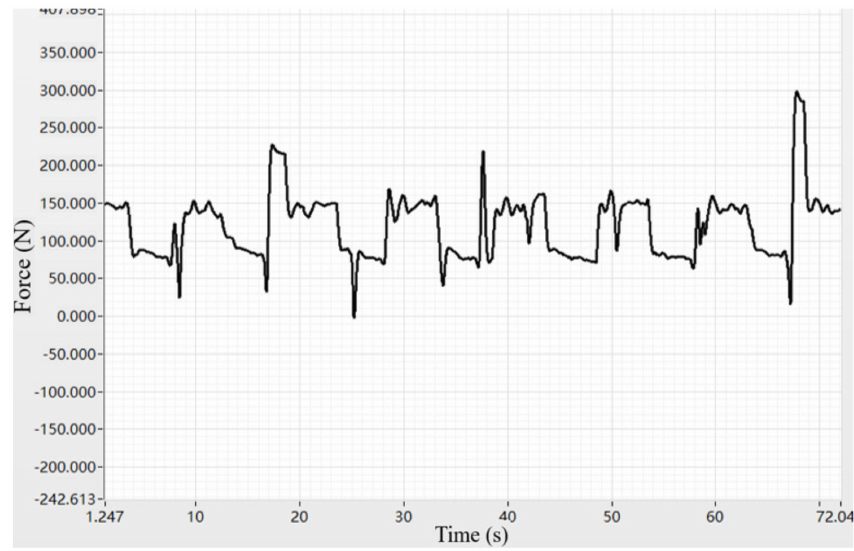
Figure 22. Lateral force waveform under random command.